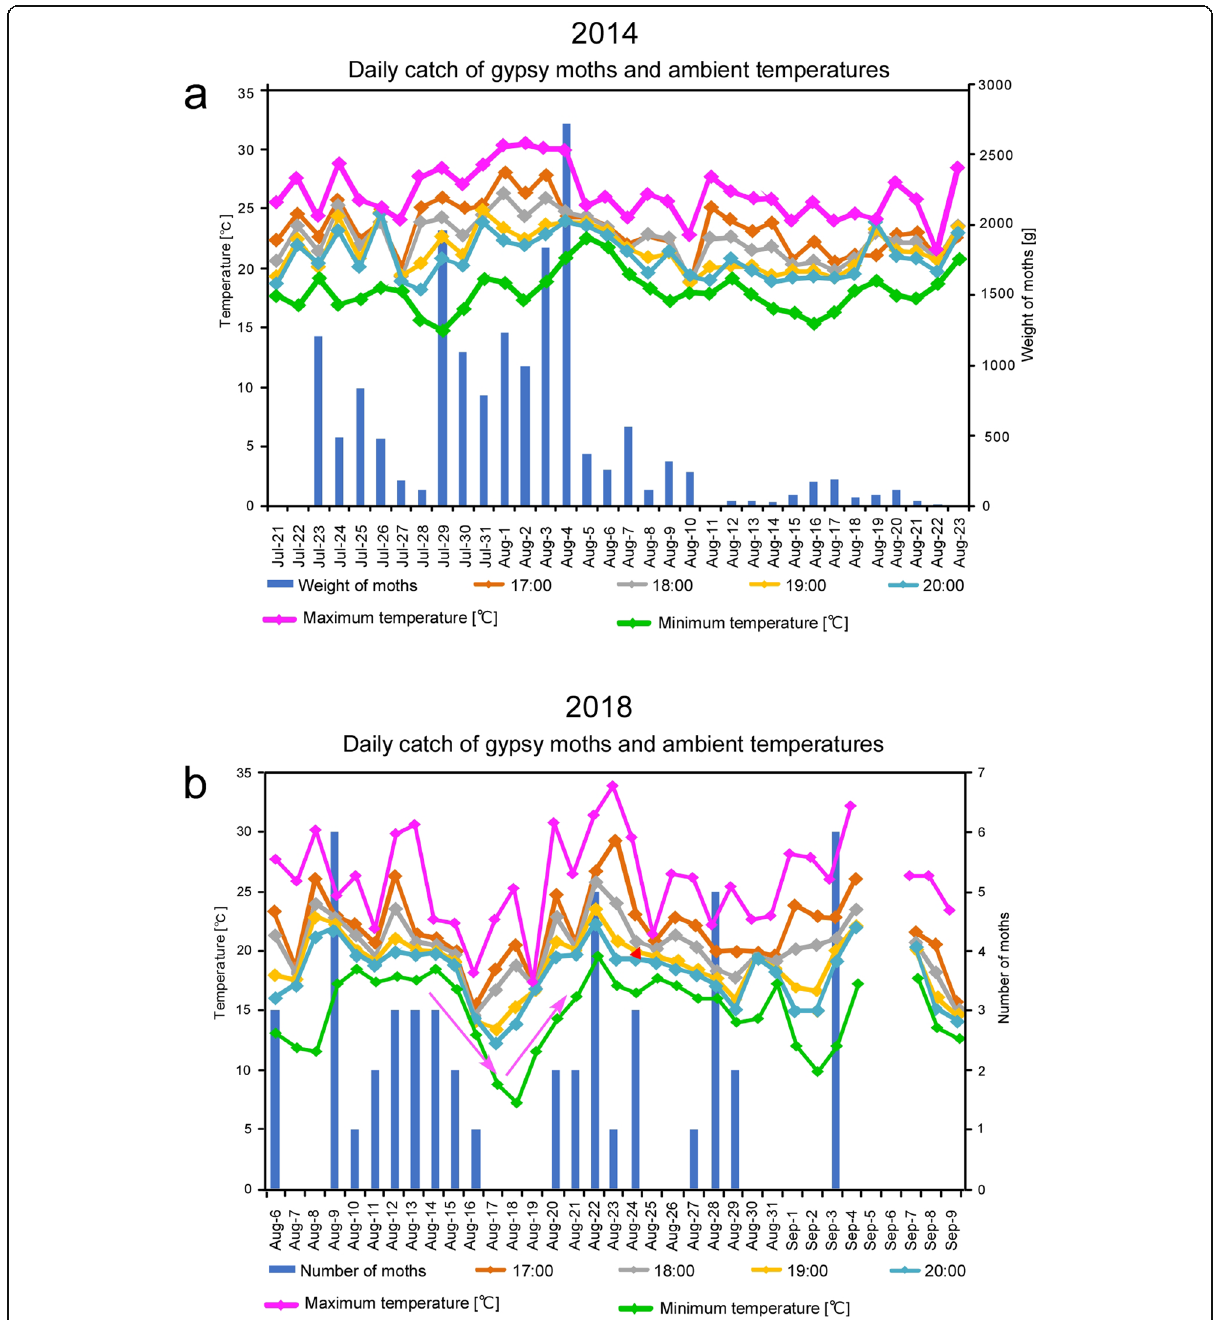
Fig. 7 Relationships between daily capture of gypsy moths and temperatures. The total numbers of moths attracted to all light traps set at Mt. Usu 2014 ( a ) and Yubari 2018 ( b ) were